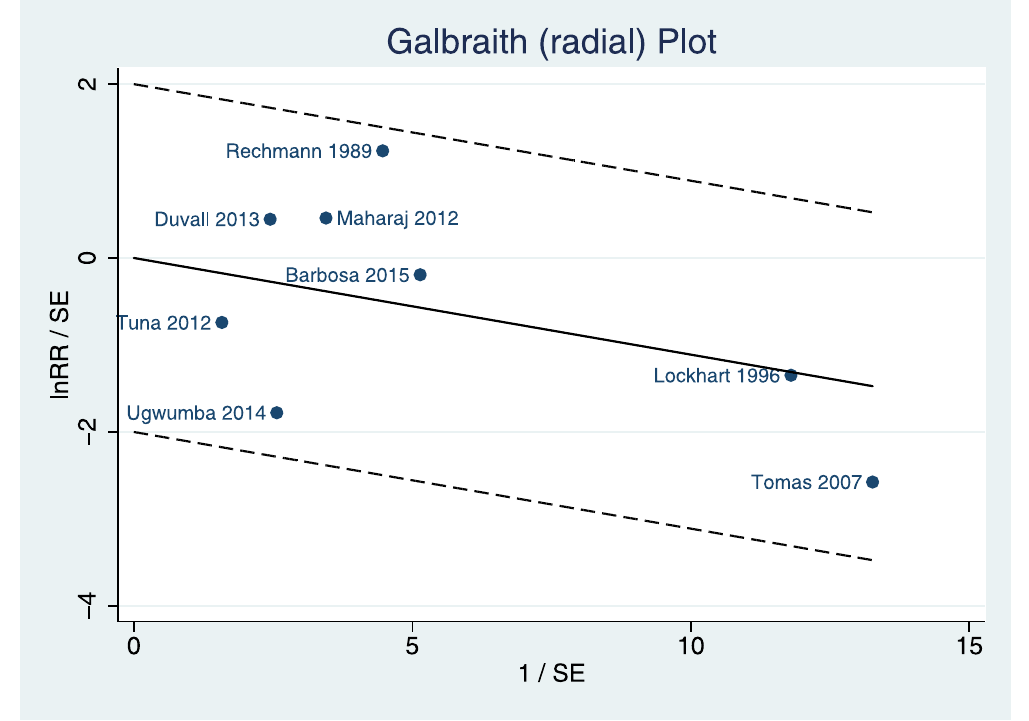
Fig 4. Galbraith (radial) plot for trials that used chlorhexidine for the prevention of post-extraction bacteremia. It can be observed that all studies are within the confidence intervals. (RR) = Relative risks. Table 3. Number needed to treat (NNT) or number needed to harm (NNH) of each study and the global NNT. Author. (year)